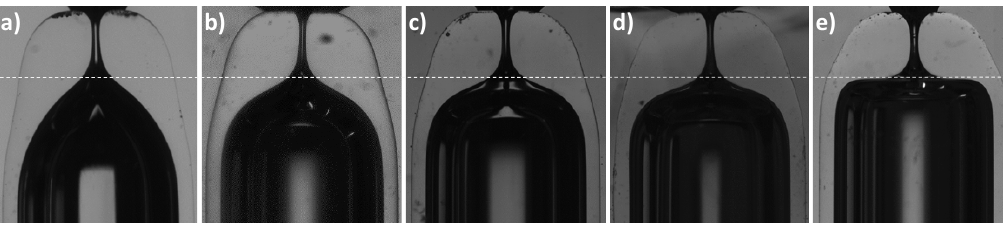
Figure 6. Nozzles of D ≈ 135 µ m manufactured at different positions: ( a ) r = 3.5 mm, t = 150 s, ∆ L = 1.47 mm; ( b ) r = 4 mm, t = 250 s, ∆ L = 1.40 mm; ( c ) r = 4.5 mm, t = 325 s, ∆ L = 1.26 mm; ( d ) r = 5 mm, t = 600 s, ∆ L = 1.22 mm; ( e ) r = 5.5 mm, t = 2000 s, ∆ L = 1.14 mm. The line is to guide the eye.